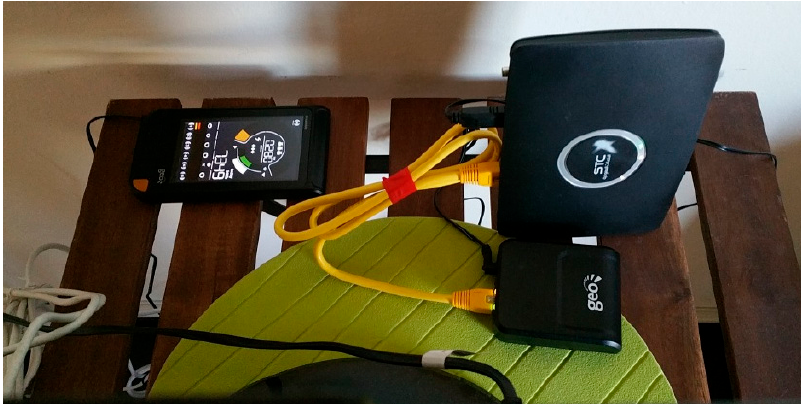
Figure 4. Display, bridge, and modem/router 3G installed for data transmission and feedback system information.